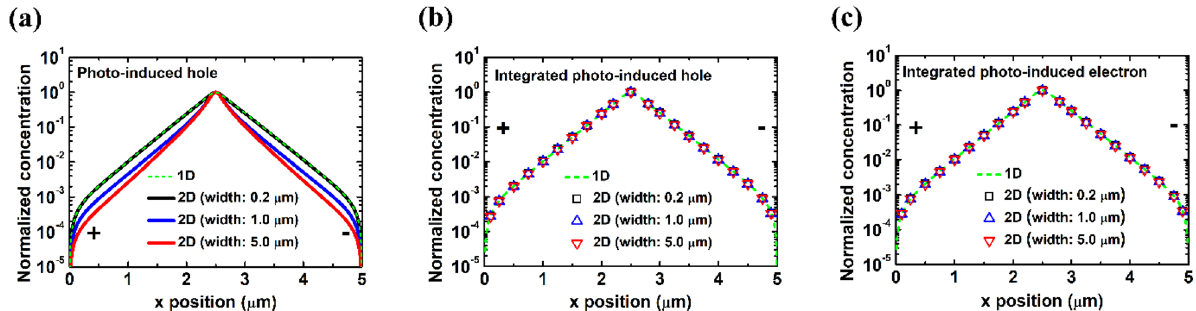
Figure 2. Excitation position is fixed at 2.5 μm. ( a ) Photo-induced hole distribution along y = 0 μm. y -direction-integrated photo-induced ( b ) hole and ( c ) electron distribution along the channel. The green dashed line represents to the photo-induced carrier distribution along channel in the 1D transport structure, which we used our previous 1D simulator in calculation. Fitted decay length extracted from ( b ) is around 0.325